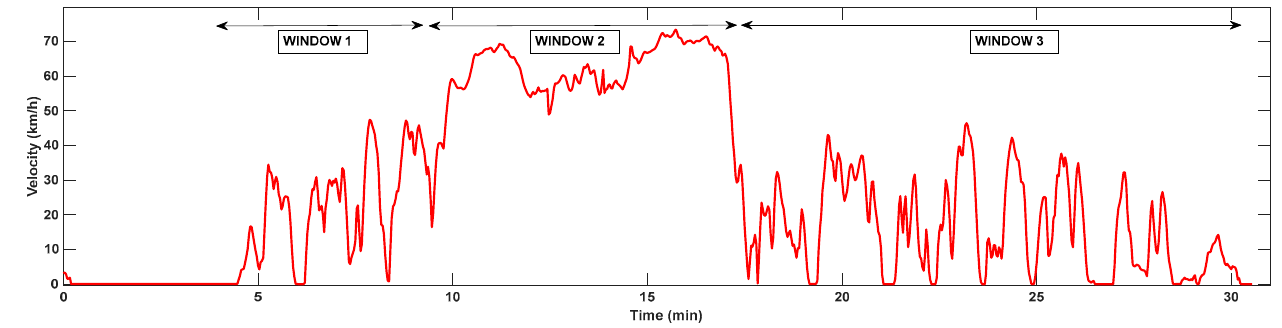
Figure 6. Tuning the simulation using variably sized windows applied based on the driving